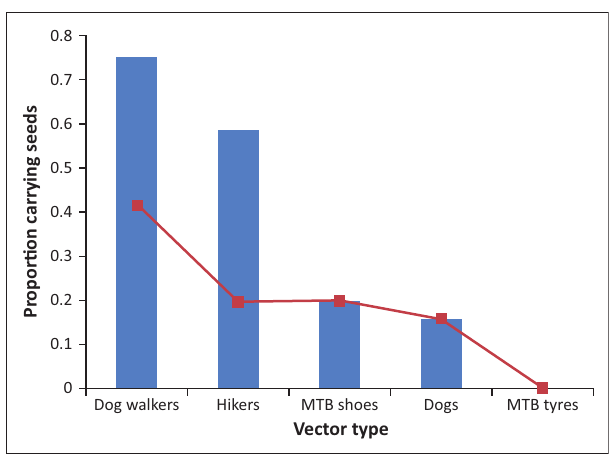
MTB, mountain bike. FIGURE 3: The proportion of seeds collected from each vector, calculated from the number of seeds divided by vector sample size, to account for sampling effort and population sample size. The black line represents the number of different seed morphs found per vector as a proportion of total seed morphs